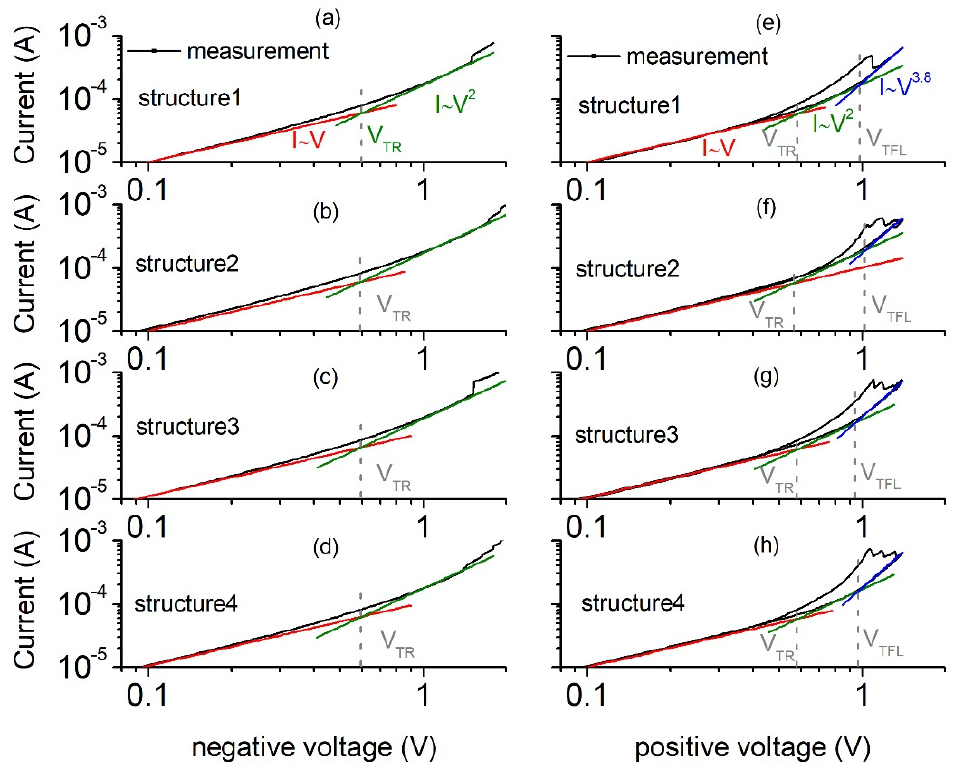
Figure 3. Slope of the current–voltage characteristics in the log-log scale for different Al/SiO 2 /n++ Si structures for the negative ( a – d ) and positive ( e – h ) voltages.